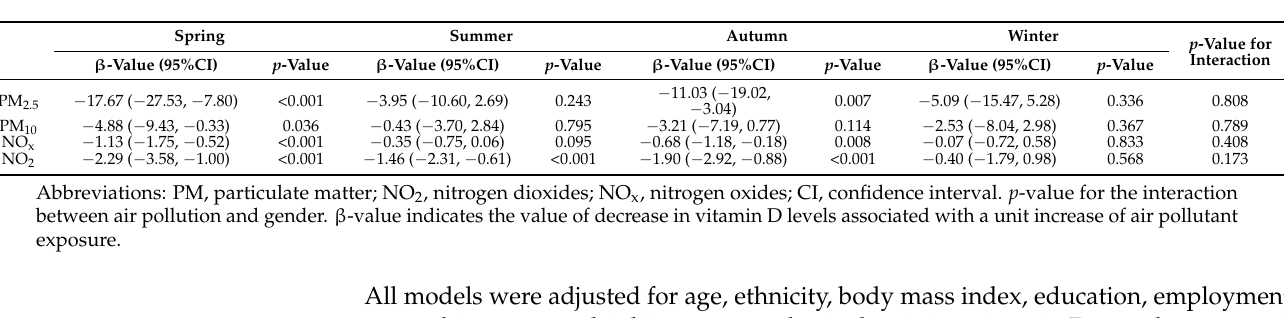
Table 5. Associations between air pollution (per 10 µ g/m 3 increase) and vitamin D in subgroups stratified by season of blood